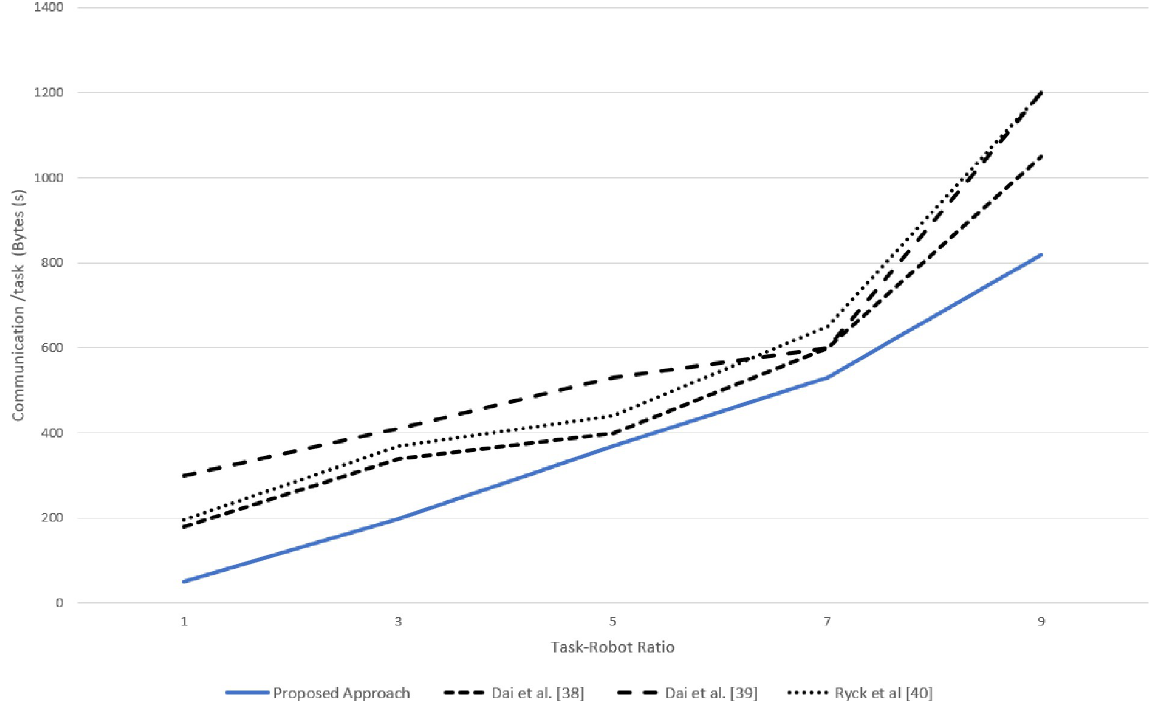
Fig 15. Simulation results for communication burden for various task-robot ratio.